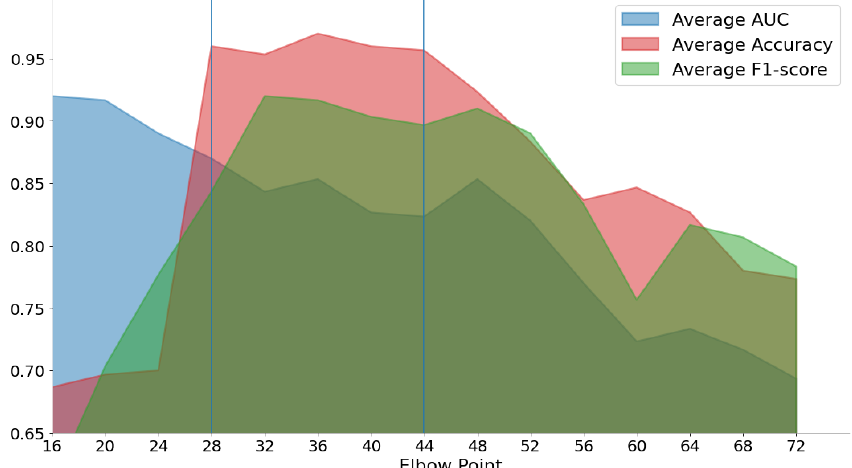
Figure 5. Elbow point detection